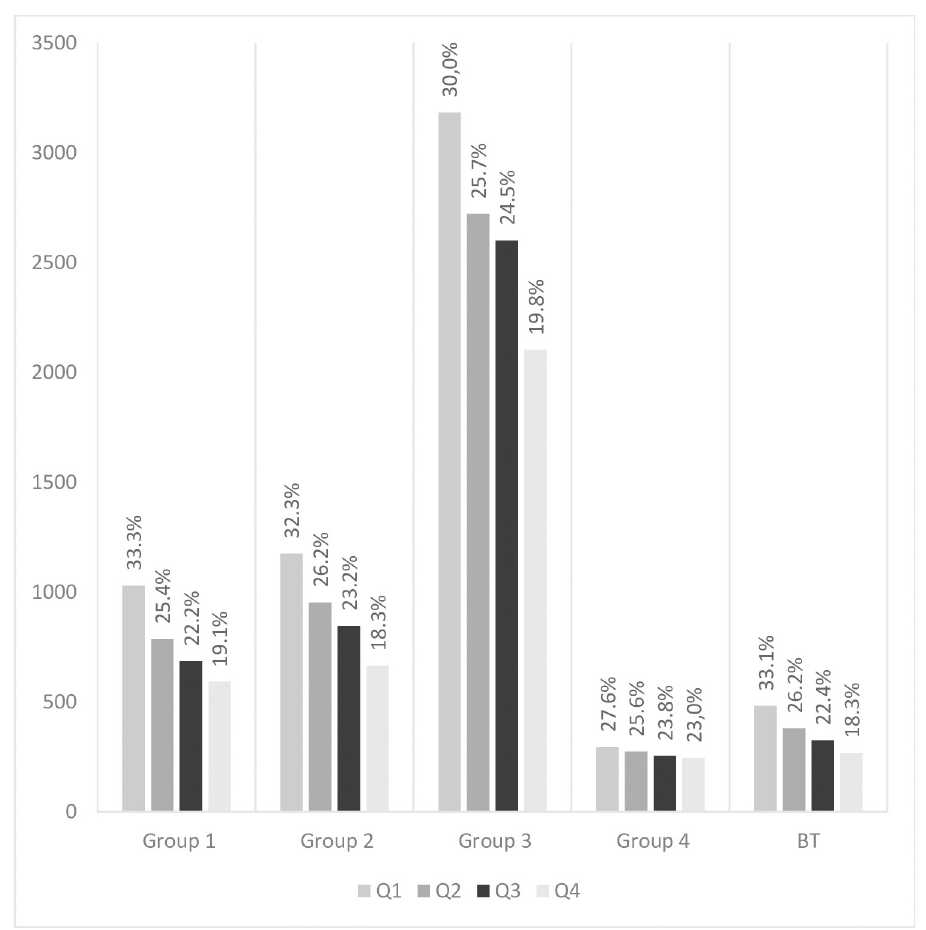
Fig 2. Distribution of players by quarter of birth in Groups 1–4 and BT.